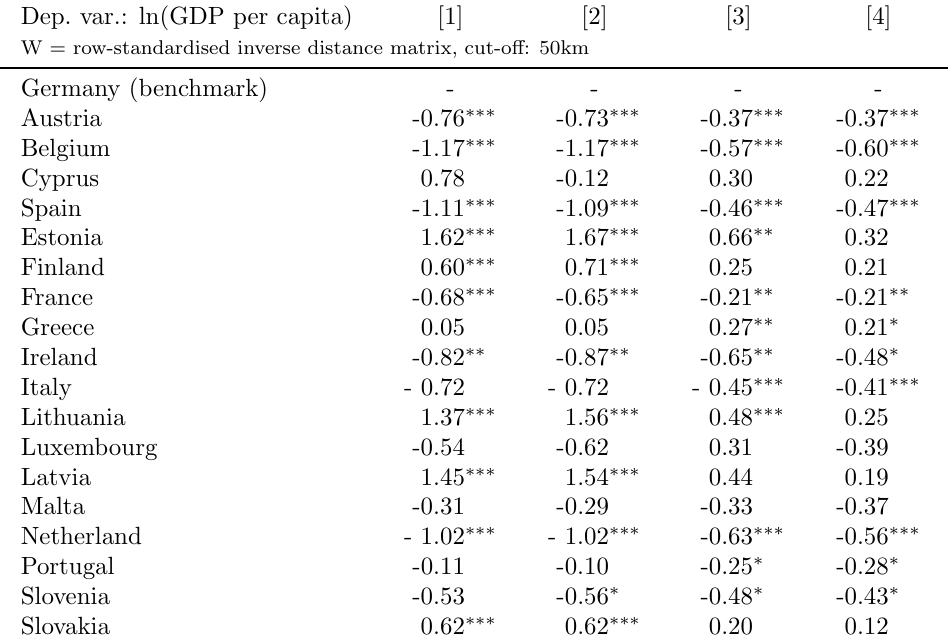
Table A.2: Empirical Results - Random effect - EA sample country dummy coefficients (total